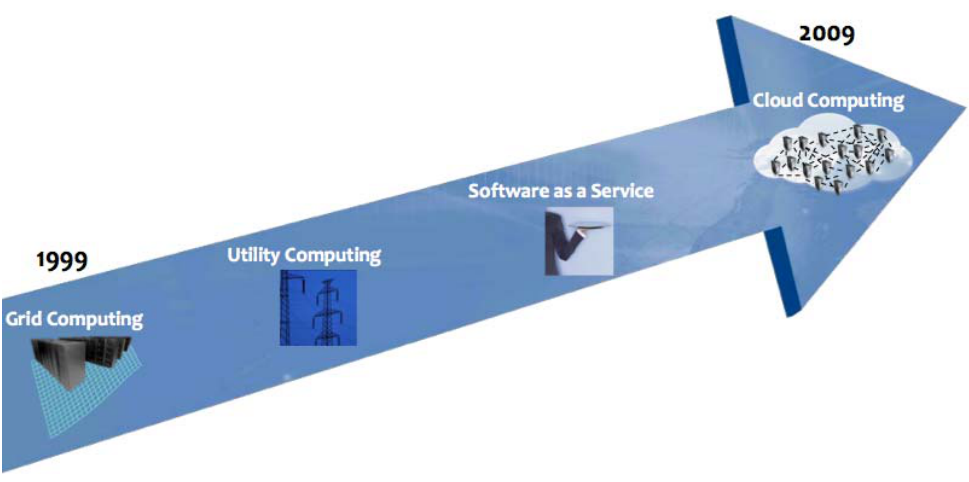
Fig. 1. Evolution of technology leading to Cloud